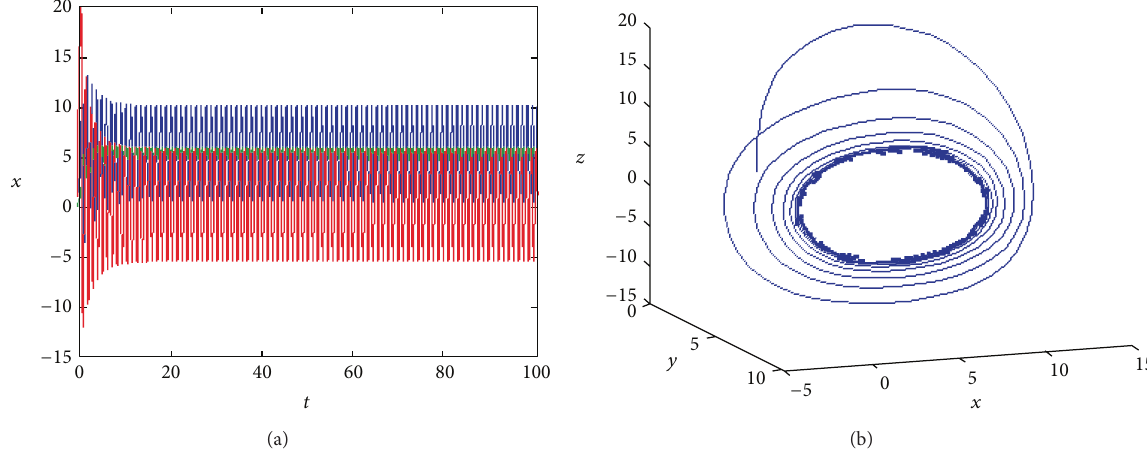
Figure 6: Time history and phase diagram of system (31) with 𝑎 = −0.5 , 𝑏 = 25 , 𝑘 = −0.1